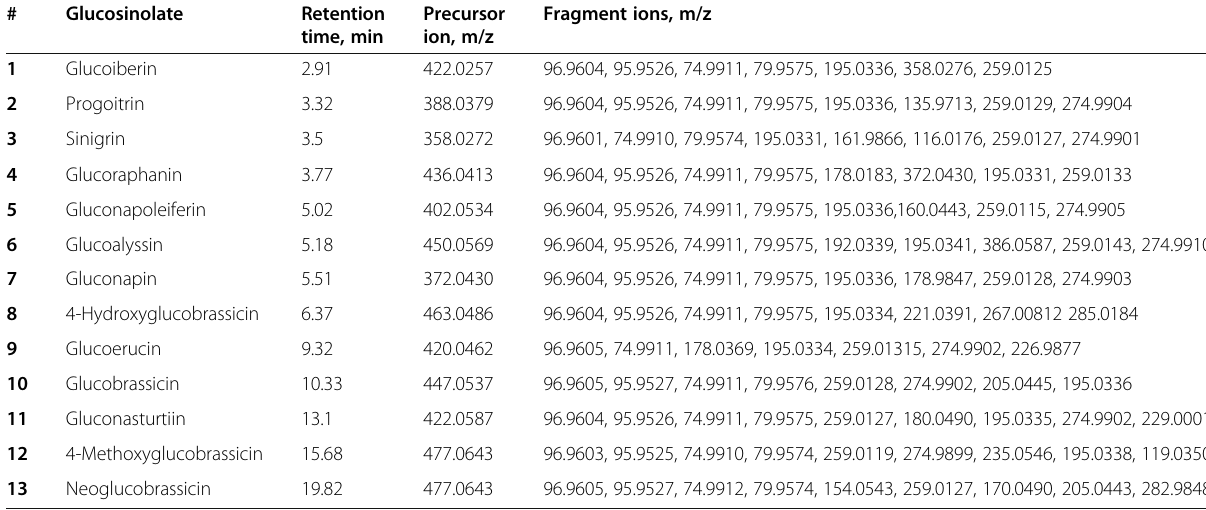
Table 2 Glucosinolates identified by LC-HRMS/MS.